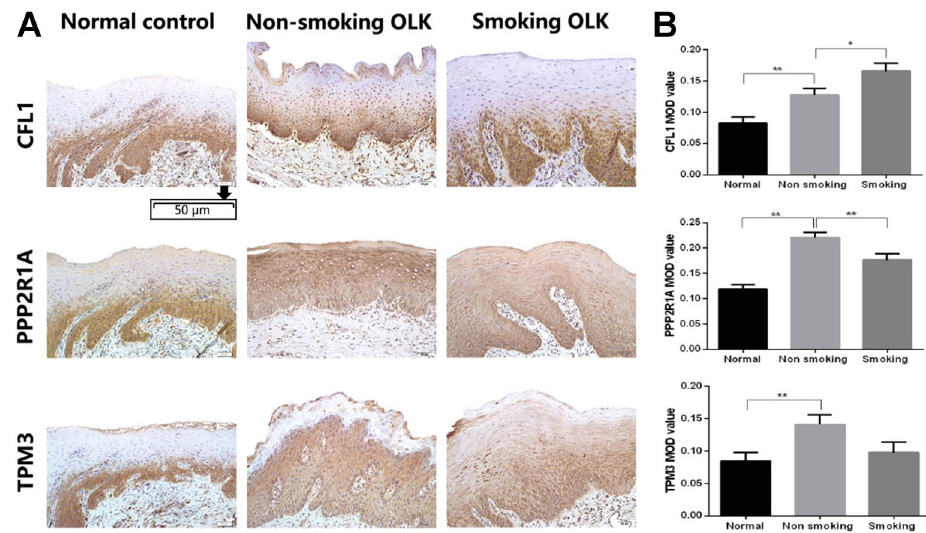
Figure 4. Immunohistochemical analysis of CFL1, PPP2R1, and TPM3 in human normal mucosa and oral leukoplakia (OLK) tissues of smokers and non-smokers. A , Representative images of PPP2R1, TPM3, and CFL1 in normal mucosa and OLK tissues ( (cid:3) 200, scale bar 50 m m). B , The integral optical density (IOD)/measurement area (MOD) values are reported as means ± SE. *P o 0.05; **P o 0.01 (ANOVA). 4NQO: